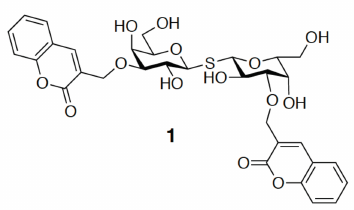
Figure 6. Molecular structure of di-substituted 3- O -coumarylmethyl thiodigalactoside ( 1